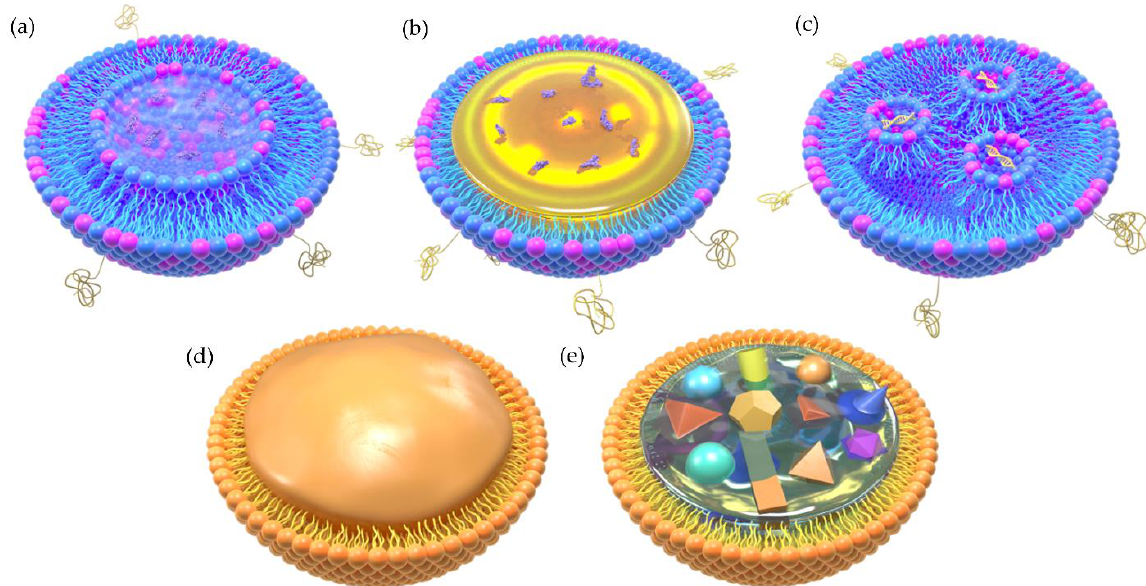
Figure 2. Schematic illumination of the two-dimensional structure of different types of LBNPs. ( a ) Liposome, ( b ) lipid nanoemulsion (LNE), ( c ) lipid nanoparticle (LNP), ( d ) solid lipid nanoparticle (SLN), ( e ) nanostructured lipid carrier (NLC).